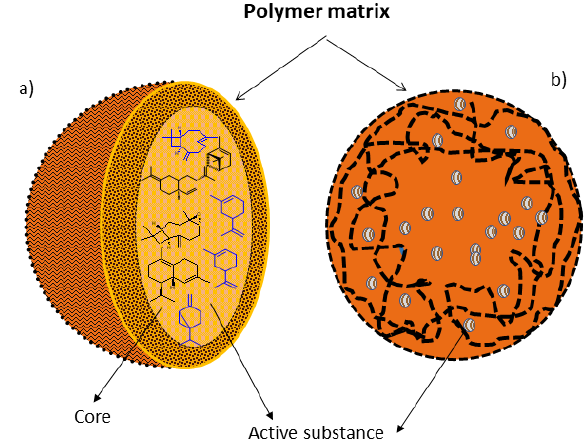
Figure 2. Polymer nanoparticles. ( a ) Nanocapsule: active ingredients dissolved in the matrix core and ( b ) Nanospheres: active ingredients dissolved throughout the polymer matrix. In the nanocapsules, the active substance is in the nucleus and is surrounded by a polymeric membrane. In the nanosphere, the active substance is dispersed in the polymeric matrix, and therefore it does not have a defined